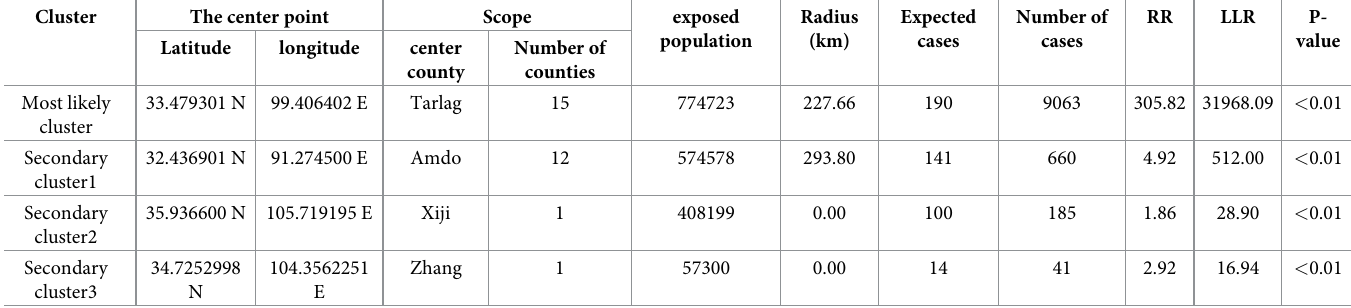
Fig 7. The spatial aggregation analysis of human AE in China in 2018. The base layer is from https://www.webmap.cn/mapDataAction.do?method=forw&resType= 5&storeId=2&storeName=%E5%9B%BD%E5%AE%B6%E5%9F%BA%E7%A1%80%E5%9C%B0%E7%90%86%E4%BF%A1%E6%81%AF%E4%B8%AD%E5%BF% 83&fileId=BA420C422A254198BAA5ABAB9CAAFBC1 with credit to National Catalogue Service For Geographic Information. https://doi.org/10.1371/journal.pntd.0009996.g007 Table 7. Spatial clustering analysis for human AE in